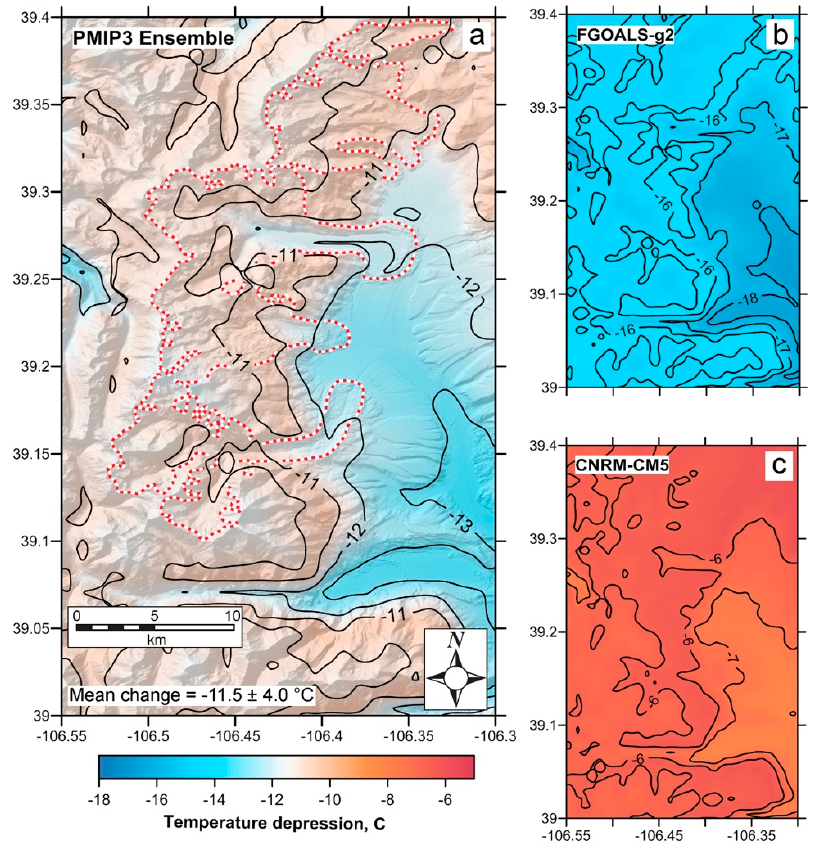
Figure 7. LGM temperature depression from ( a ) the CHELSA downscaled PMIP3 ensemble, and ( b ) the coldest and ( c ) warmest scenarios within the ensemble. Glacier areas (simplified) used for clipping the CHELSA grids are indicated by the red and white lines in (a).